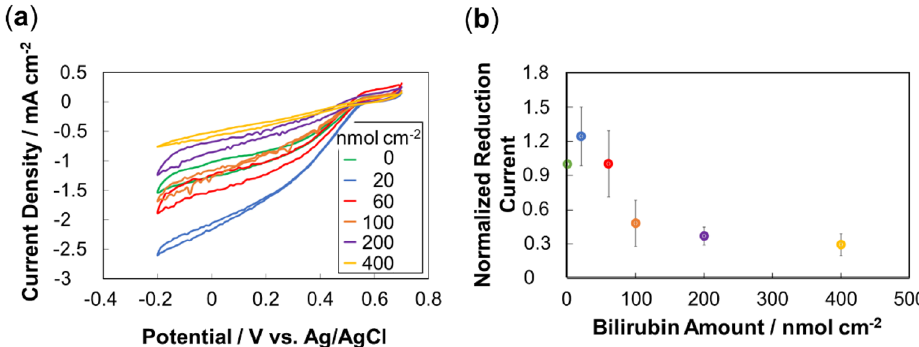
Figure 5. Electrochemical evaluation of biocathodes with BOD adsorbed on MgOC with bilirubin as guide for orientation. CE = Pt wire; RE = Ag/AgCl/sat. KCl; 1 M phosphate buffer, pH 7.0. ( a ) Cyclic voltammograms. Legend: bilirubin amount. ( b ) Normalized reduction current obtained chronoamperometrically vs. bilirubin amount used for immobilizing BOD. 0.3 V vs. Ag/AgCl/sat. KCl. Current for electrode with BOD immobilized in absence of bilirubin =